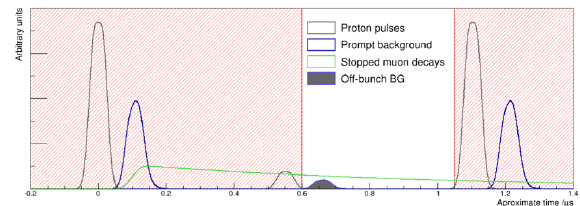
Figure 1. Cartoon of the delayed window technique. The prompt backgrounds (blue) should all occur a few hundred nanoseconds after the primary beam time, while the signal occurs according to the lifetime of the muonic atoms, which is matched to the bunch frequency. An important aspect is whether there are non- negligible o ff -time bunches (grey fill). In reality, such a back- ground is not expected to be a problem, as described in the next